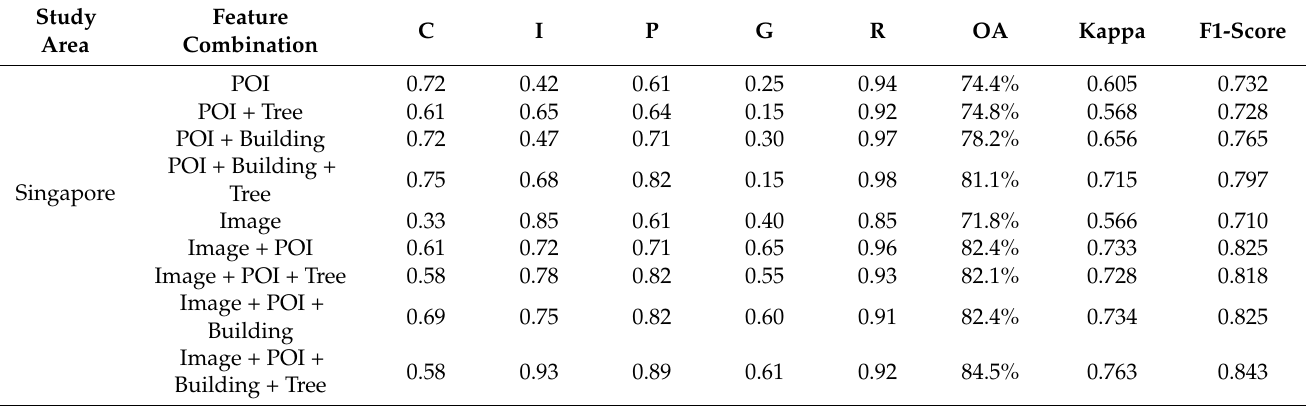
Table 9. UFZ classification results in Singapore based on different feature